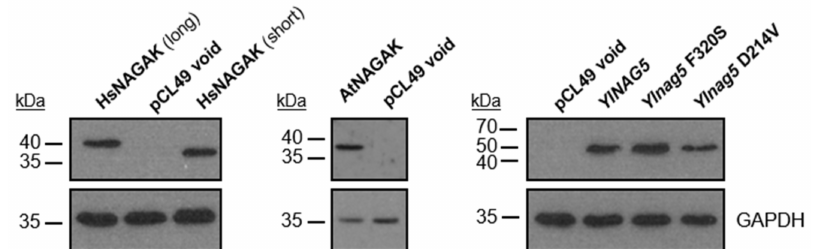
Figure 4. Immunoblot analysis of the expression of heterologous NAGA kinases and of mutated forms of Y. lipolytica NAGA kinase. Captions above each lane indicate the protein expressed. Glycer- aldehyde 3-P dehydrogenase (GAPDH) is shown as control protein for loading and transfer efficiency. Treatment of samples, blot procedure and antibodies used in each case are described in Section 4.5 of Material and